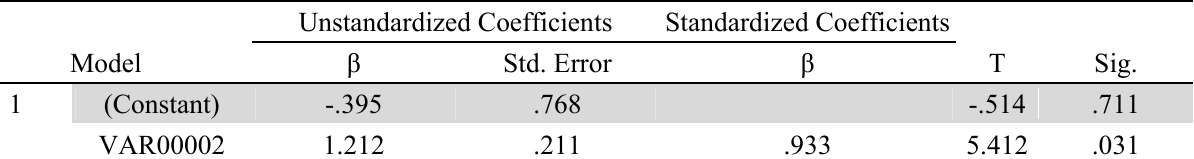
The summary of regression